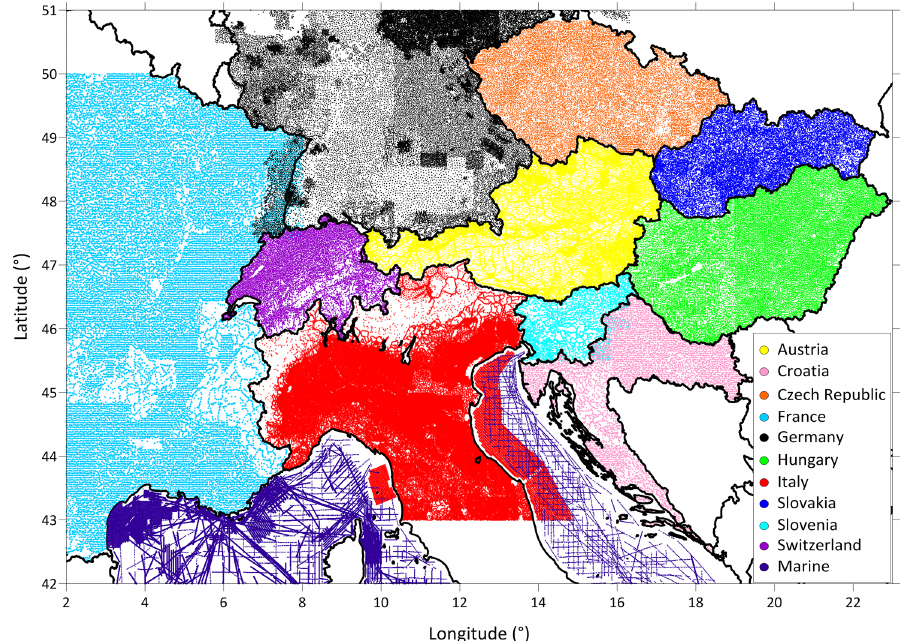
Figure 1. The distribution of more than 1 million gravity stations in the area of investigation and compilation. Colors indicate the national databases used in the compilation.